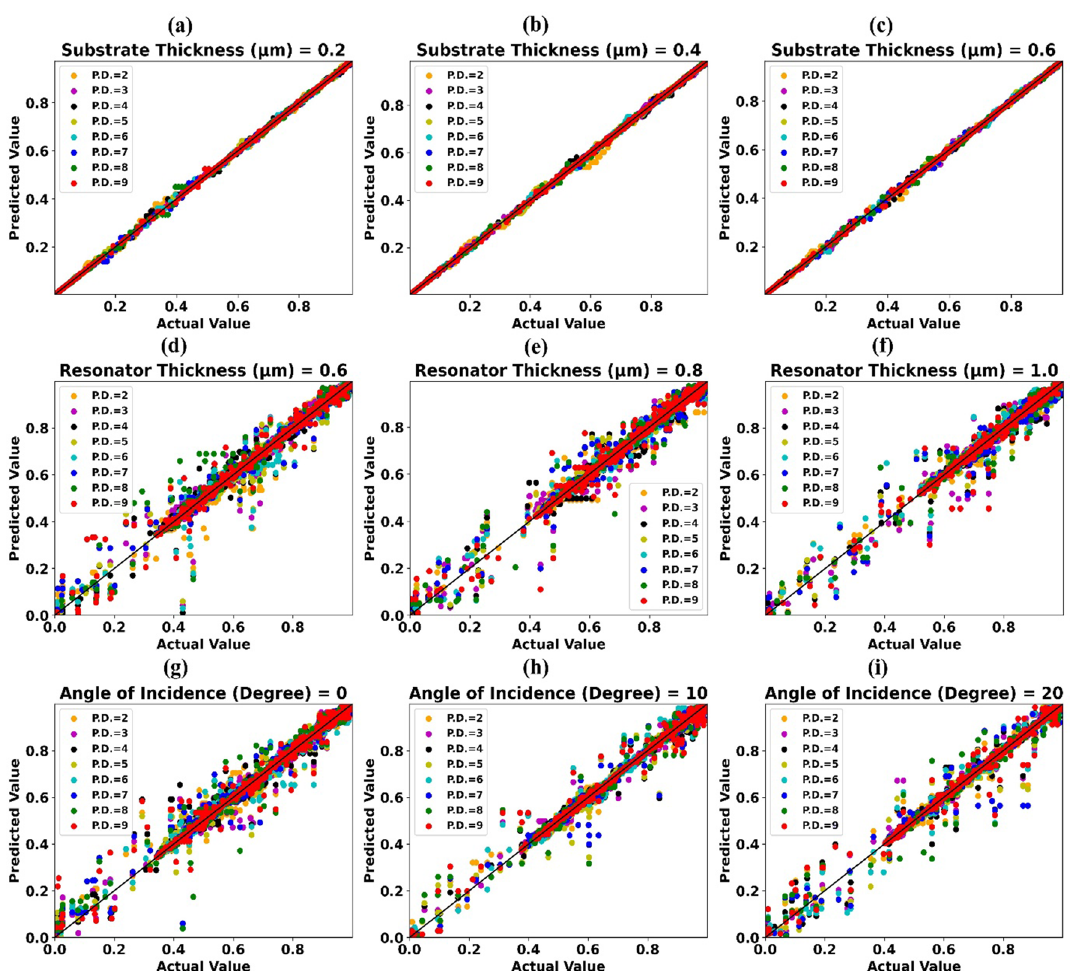
Figure 7. Predicted absorption value by different 1D CNN Regressors vs Actual absorption value for test case C-0.5 and ( a ) Substrate thickness = 0.2 µm ( b ) Substrate thickness = 0.4 µm ( c ) Substrate thickness = 0.6 µm ( d ) Resonator thickness = 0.6 µm ( e ) Resonator thickness = 0.8 µm ( f ) Resonator thickness = 1.0 µm ( g ) Angle of incidence = 0° ( h ) Angle of incidence = 10° ( i ) Angle of incidence =